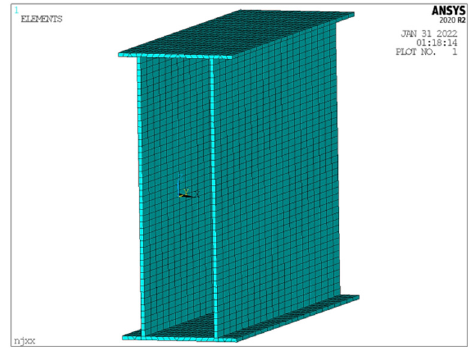
Figure 13. Discrete cell graph. Table 4. Physical parameters of steel.